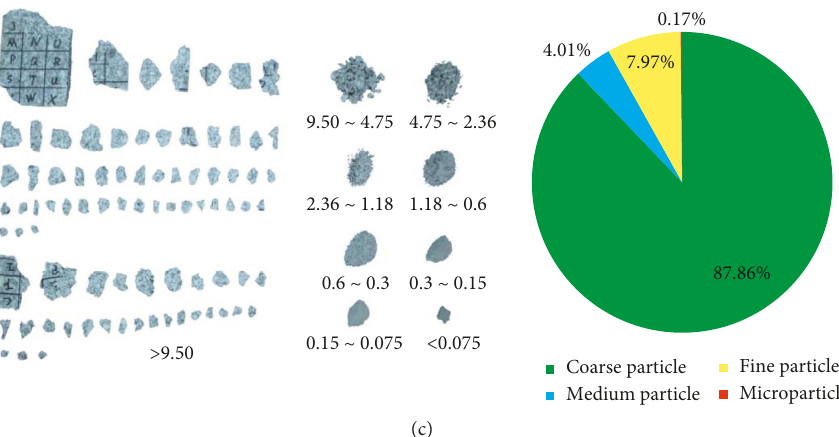
Figure 11: The size distribution of the fragments under different support forces (unit: mm): (a) σ